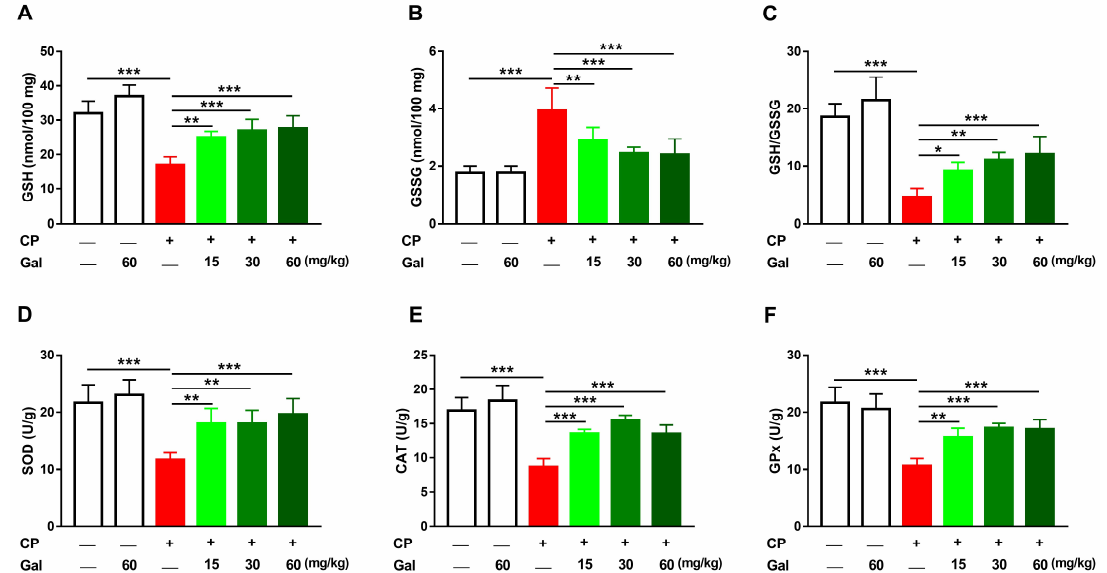
Figure 5. Galangin (Gal) enhances cellular antioxidants in CP-intoxicated rats. Gal increased ( A ) Reduced glutathione (GSH), ( C ) GSH / glutathione disulfide (GSSG) ratio, and activity of ( D ) superoxide dismutase (SOD), ( E ) catalase (CAT), and ( F ) glutathione peroxidase (GPx), and decreased GSSG ( B ) in the liver of CP-intoxicated rats. Data are mean ± SEM, ( N = 6). * P < 0.05, ** P < 0.01, and *** P < 0.001.